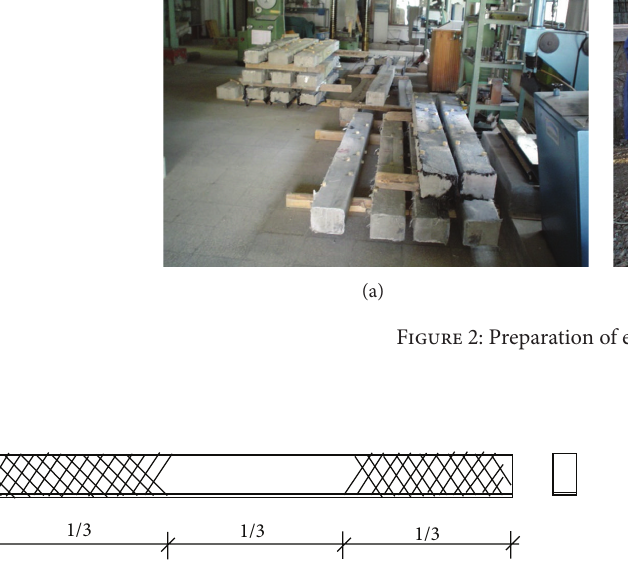
Figure 3: CFRP and GFRP application on concrete beams.